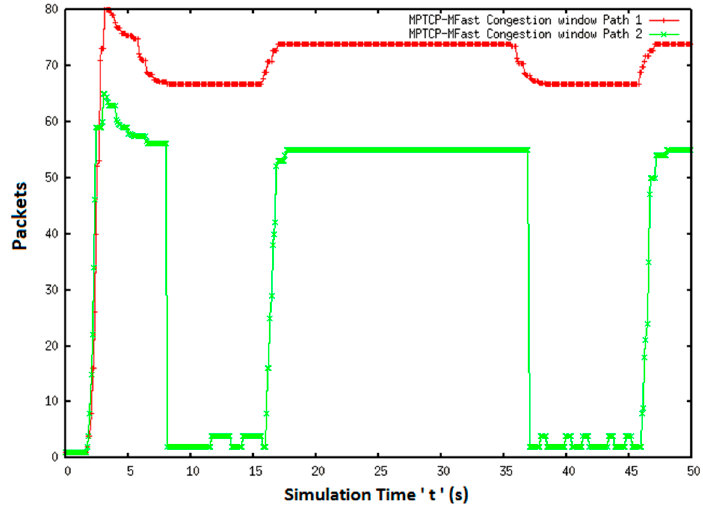
Figure 9. Congestion Windows of individual subflows belonging to MPTCP modified Fast TCP (MPTCP-MFast).